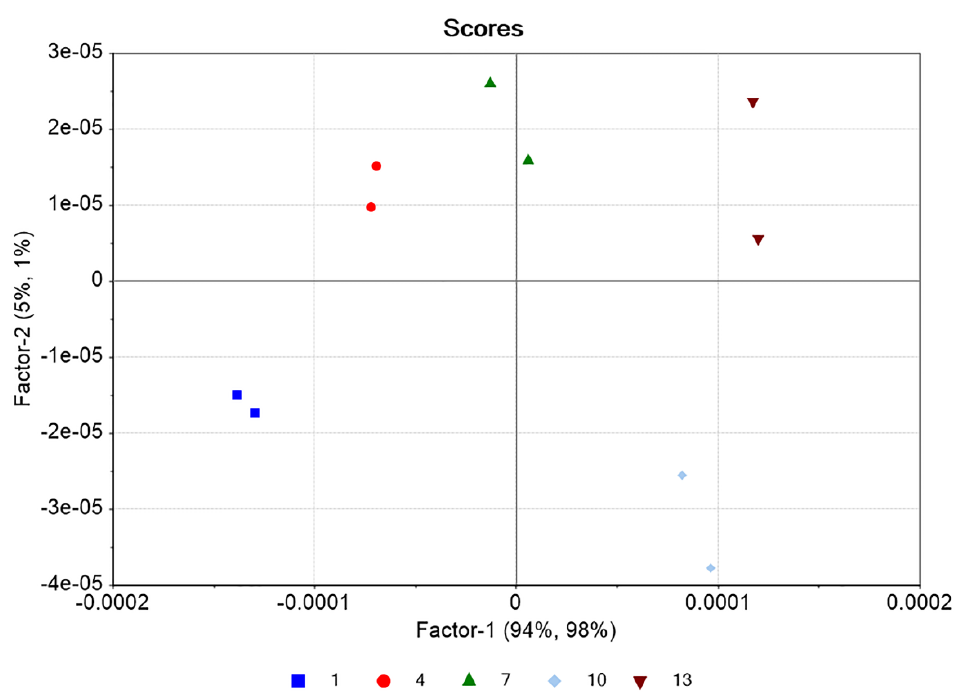
Figure 4. Scores plot of the training set (blue: 1 g/L, red: 4 g/L, green: 7 g/L, cyan: 10 g/L, brown: 13 g/L of DS). Each point corresponds to a different control batch consisting of three spectra for each concentration (N total = 30 spectra).